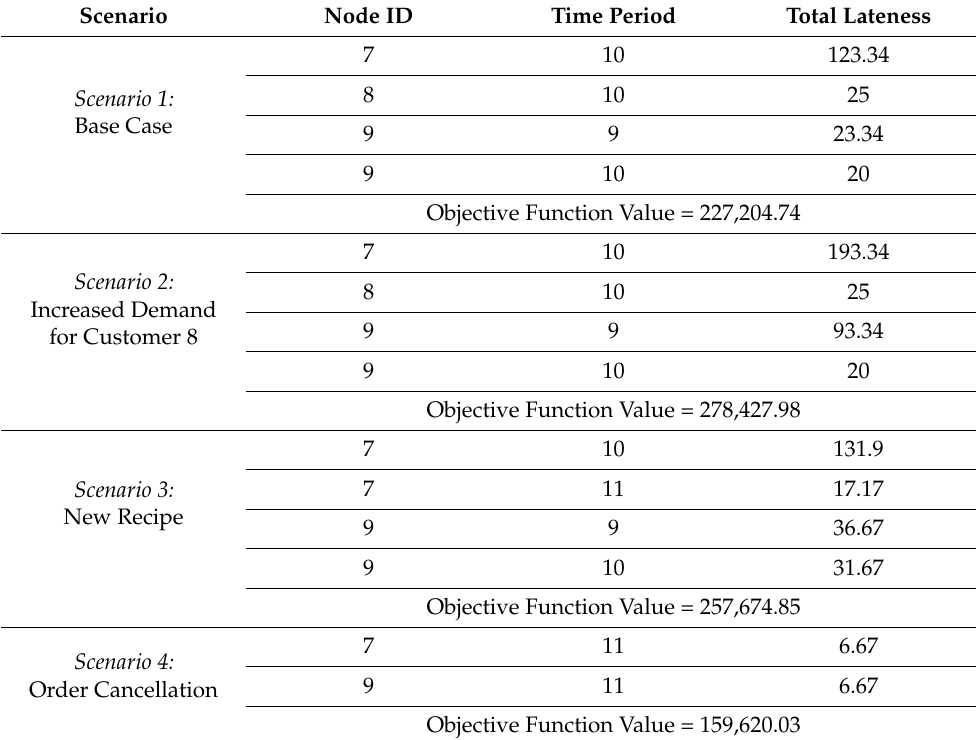
Table 6. Lateness in various